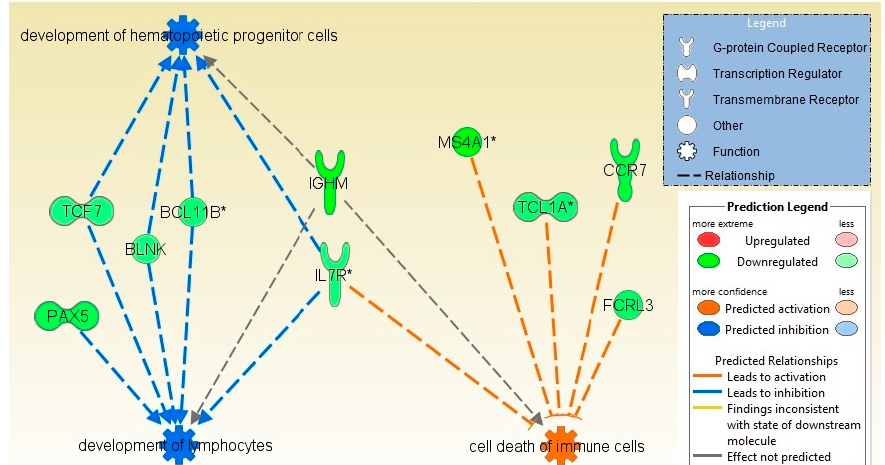
Figure 3. Functional analysis and regulatory effect of differentially expressed genes. Using Ingenuity Pathways Analysis (IPA), Differentially Expressed Genes (DEGs) were overlaid on to the network to find a biological regulatory functional effect based on previously reported interactions in the literature. Function colored with blue denote inhibition and orange denotes activation; development of hematopoietic progenitor cells and development of lymphocytes were inhibited whereas cell death of immune cells as activated function.